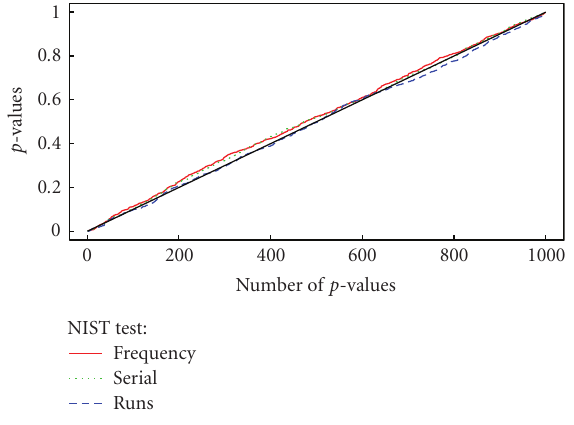
Figure 9: Selected results from the NIST suite.